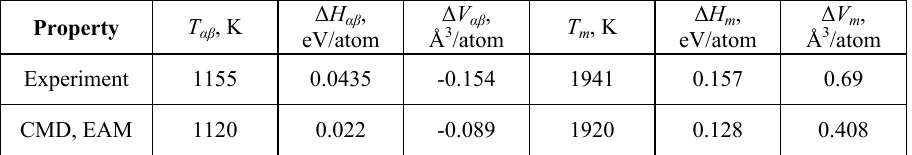
Table 1. Thermodynamically equilibrium parameters of the α-β phase transition and melting at zero pressure for pure Ti calculated within CMD using the Thermodynamic Integration Method [6,7] for the EAM interatomic potential [3] in comparison with experimental data